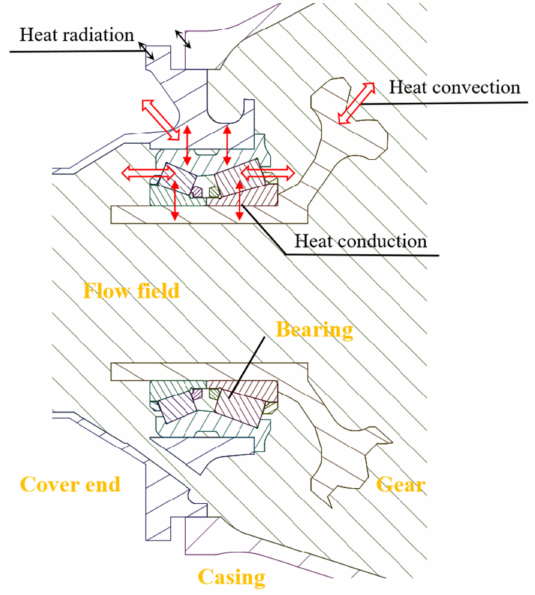
Figure 2. Heat dissipation